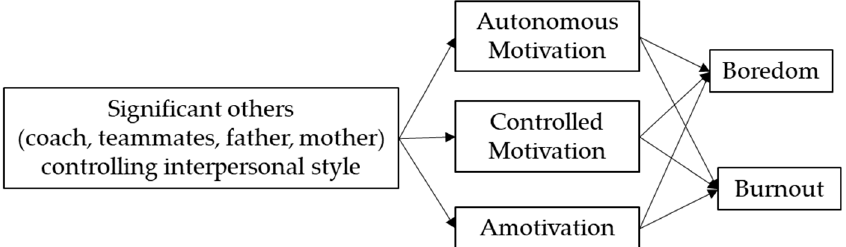
Figure 1. Hypothesized path model of the relationship between significant others’ controlling in- terpersonal style, forms of motivation, boredom, and